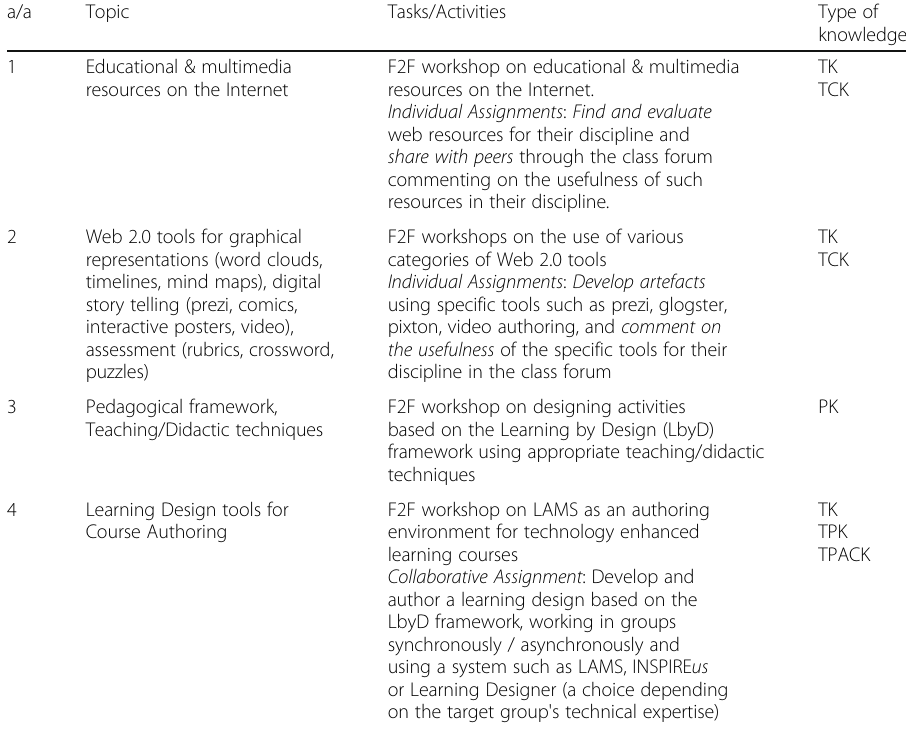
Table 1 Curriculum organized around activities cultivating solid types of knowledge, starting from TK, PK and incrementally combining them in TCK, TPK and TPACK